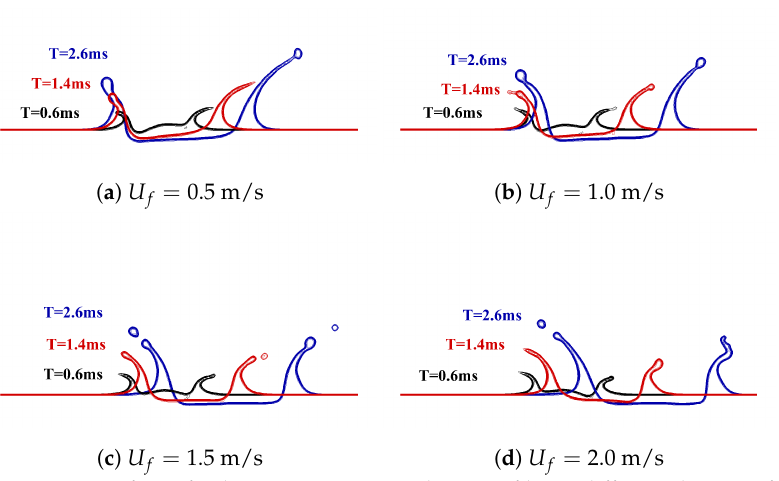
Figure 9. Interface of a drop impact upon a dynamic film at different dynamic film velocities when θ = 30 ◦ .